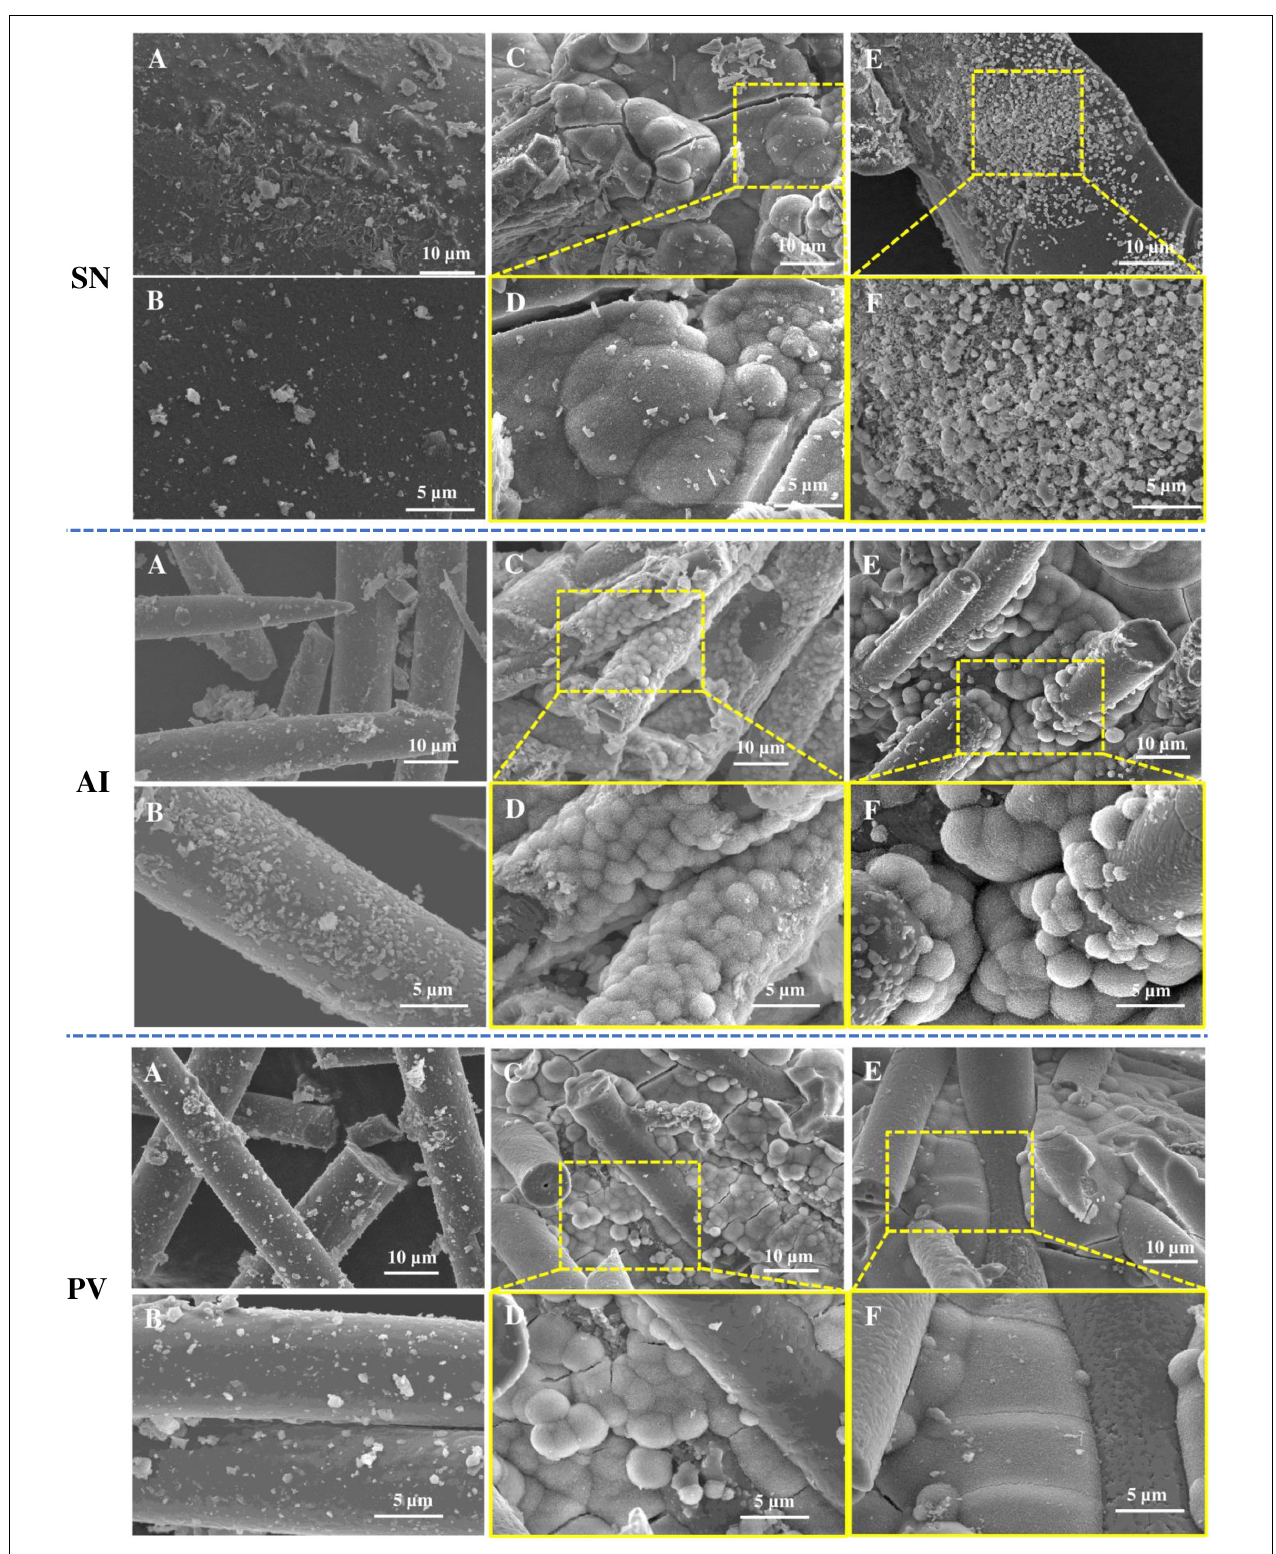
FIGURE 5 | SEM micrographs of the biosilicas obtained from SN, AI, and PV before immersion in SBF (A,B) , after 7 days of immersion in SBF (C,D) , and after 28 days of immersion in SBF (E,F) . Scale bars: 5 and 10 µ m.